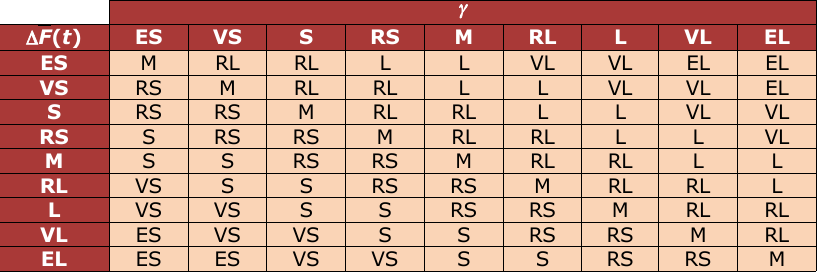
Table 4. The fuzzy logic rules of mutation